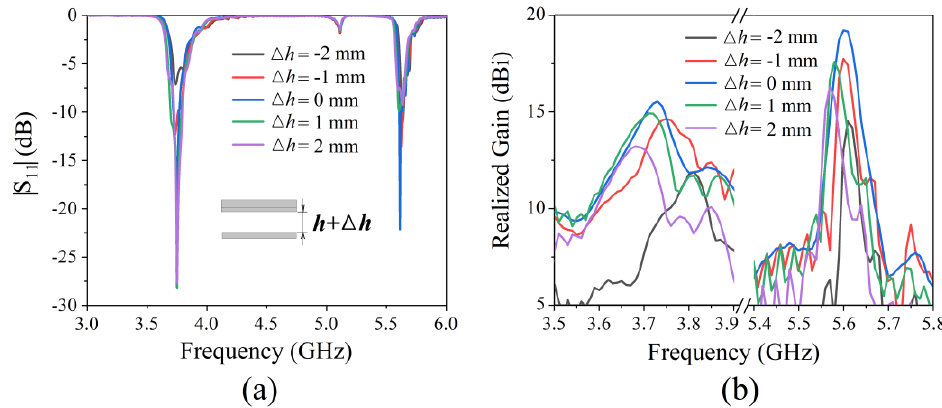
Figure 10. Simulated radiation performance for antennas with different cavity thicknesses: ( a )|S 11 |; ( b ) realized gain.